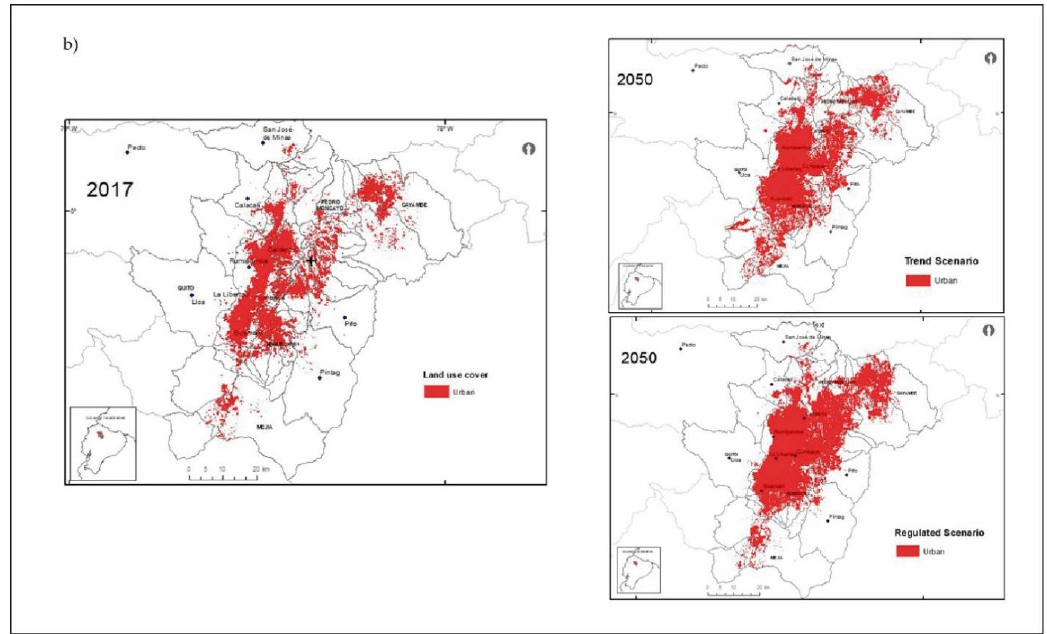
Figure 8. ( a ) Land use and cover 1998–2017 and 2050 ( b ) Urban expansion 2017 and regulated scenario vs. trend scenario 2050.